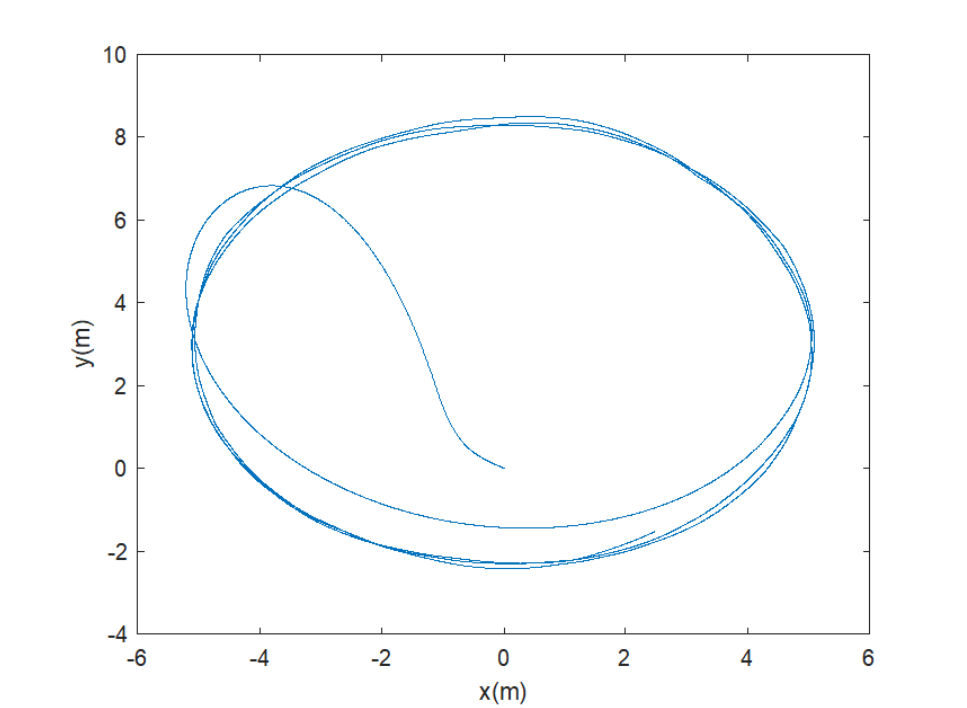
Figure 14. Bias fault: the 2D position control